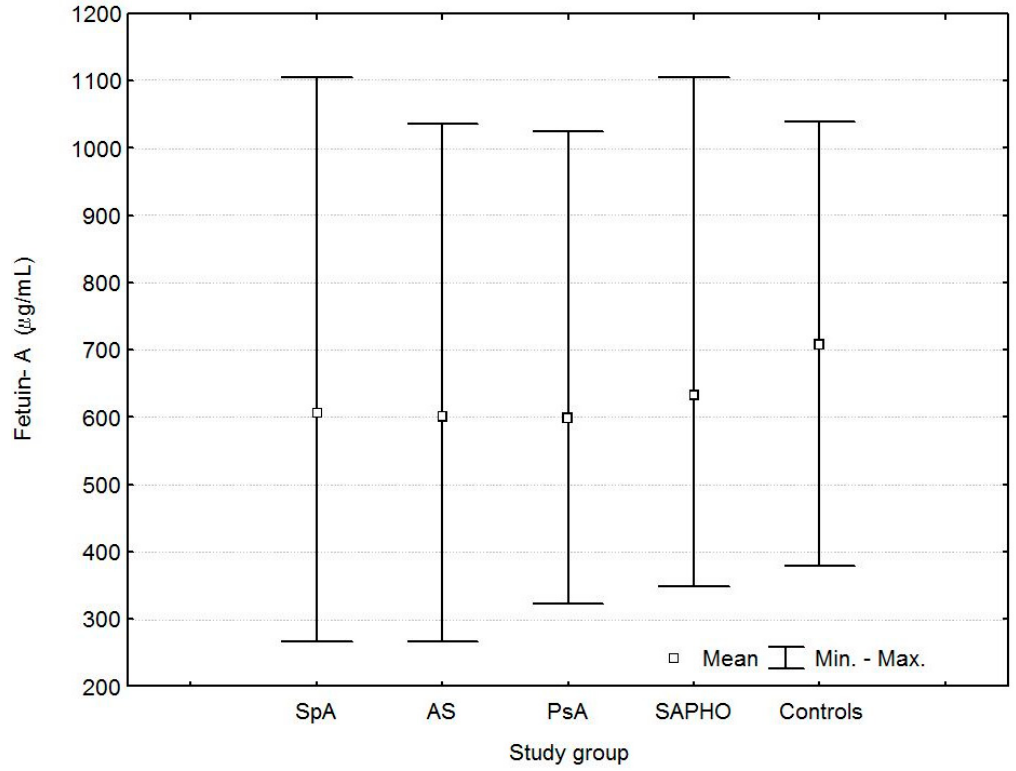
Figure 2. Serum concentrations of fetuin-A in patients with spondyloarthritis (SpA), ankylosing spondylitis (AS), psoriatic arthritis (PsA), SAPHO syndrome (SAPHO), and controls. Table 3. A logistic regression model of the odds ratio of the increased serum levels of interleukin-18, decreased serum levels of fetuin-A, increased serum levels of soluble intercellular adhesion molecule-1, and decreased serum levels of endothelin-1 in the spondyloarthritis group of patients compared to controls.